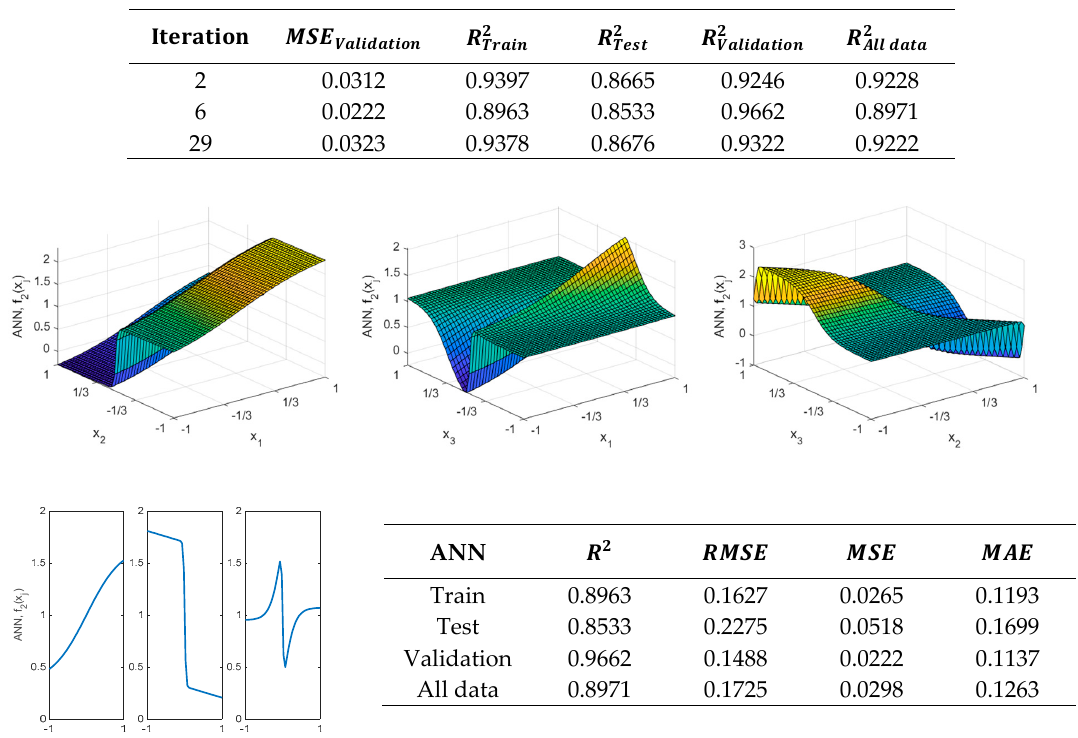
Figure 13. Response surfaces obtained, main effects plot and results of the validation metrics obtained with the ANN model for the regression in the case of type 2 function ( f 2 ) ( n = 2 neurons ).